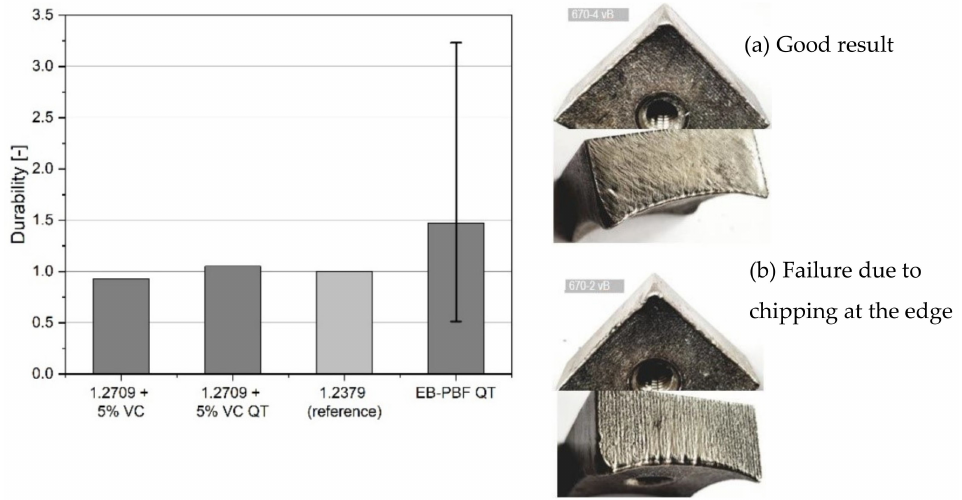
Figure 16. ( Left ) Durability factor dependent on material, whereas conventional 1.2379 is used as reference (factor 1). All PBF-EB samples showed a higher durability. ( Right) Used cutting crowns with still good shape ( a ) and impact damage ( b